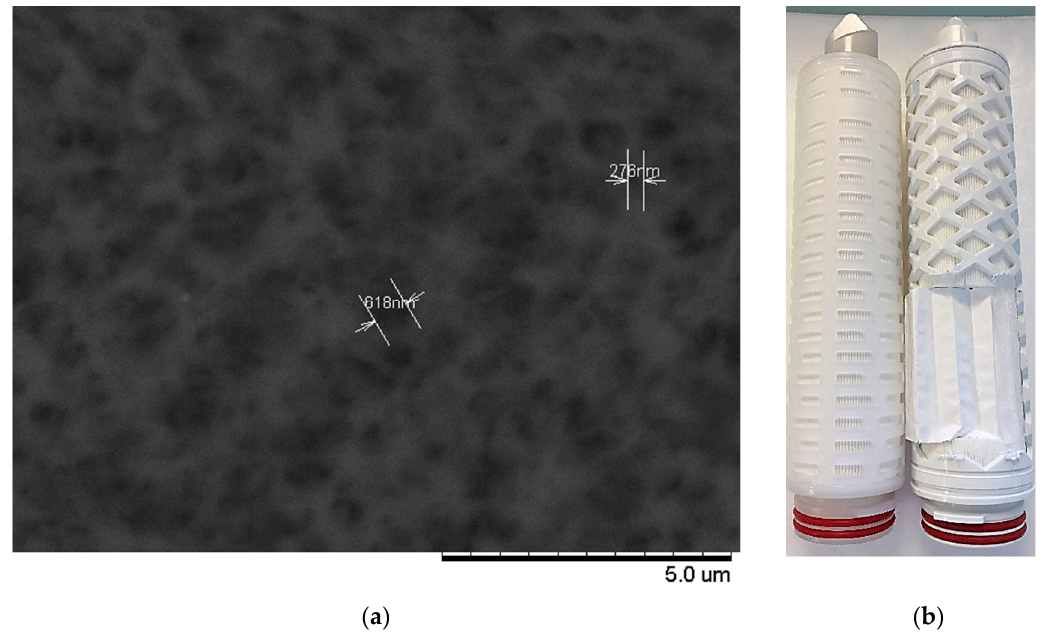
Figure 1. ( a ) Scanning electron microscopy (SEM) images of a PES 0.2 μ m membrane showing its porous structure; ( b ) cartridge used for liquid–liquid displacement porosimetry (LLDP) non-destructive analysis and unfolding for gas–liquid displacement porosimetry (GLDP) (autopsy).